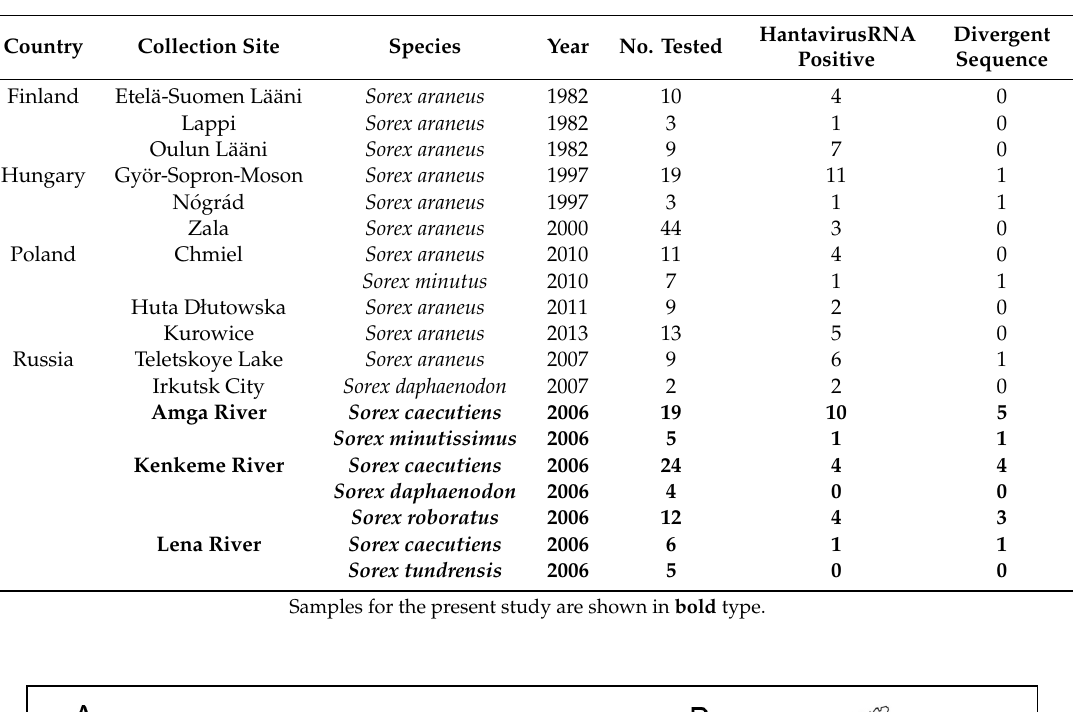
Table 1. Prevalence of hantavirus RNA and occurrence of divergent hantavirus sequence in Sorex shrews from Eurasia.